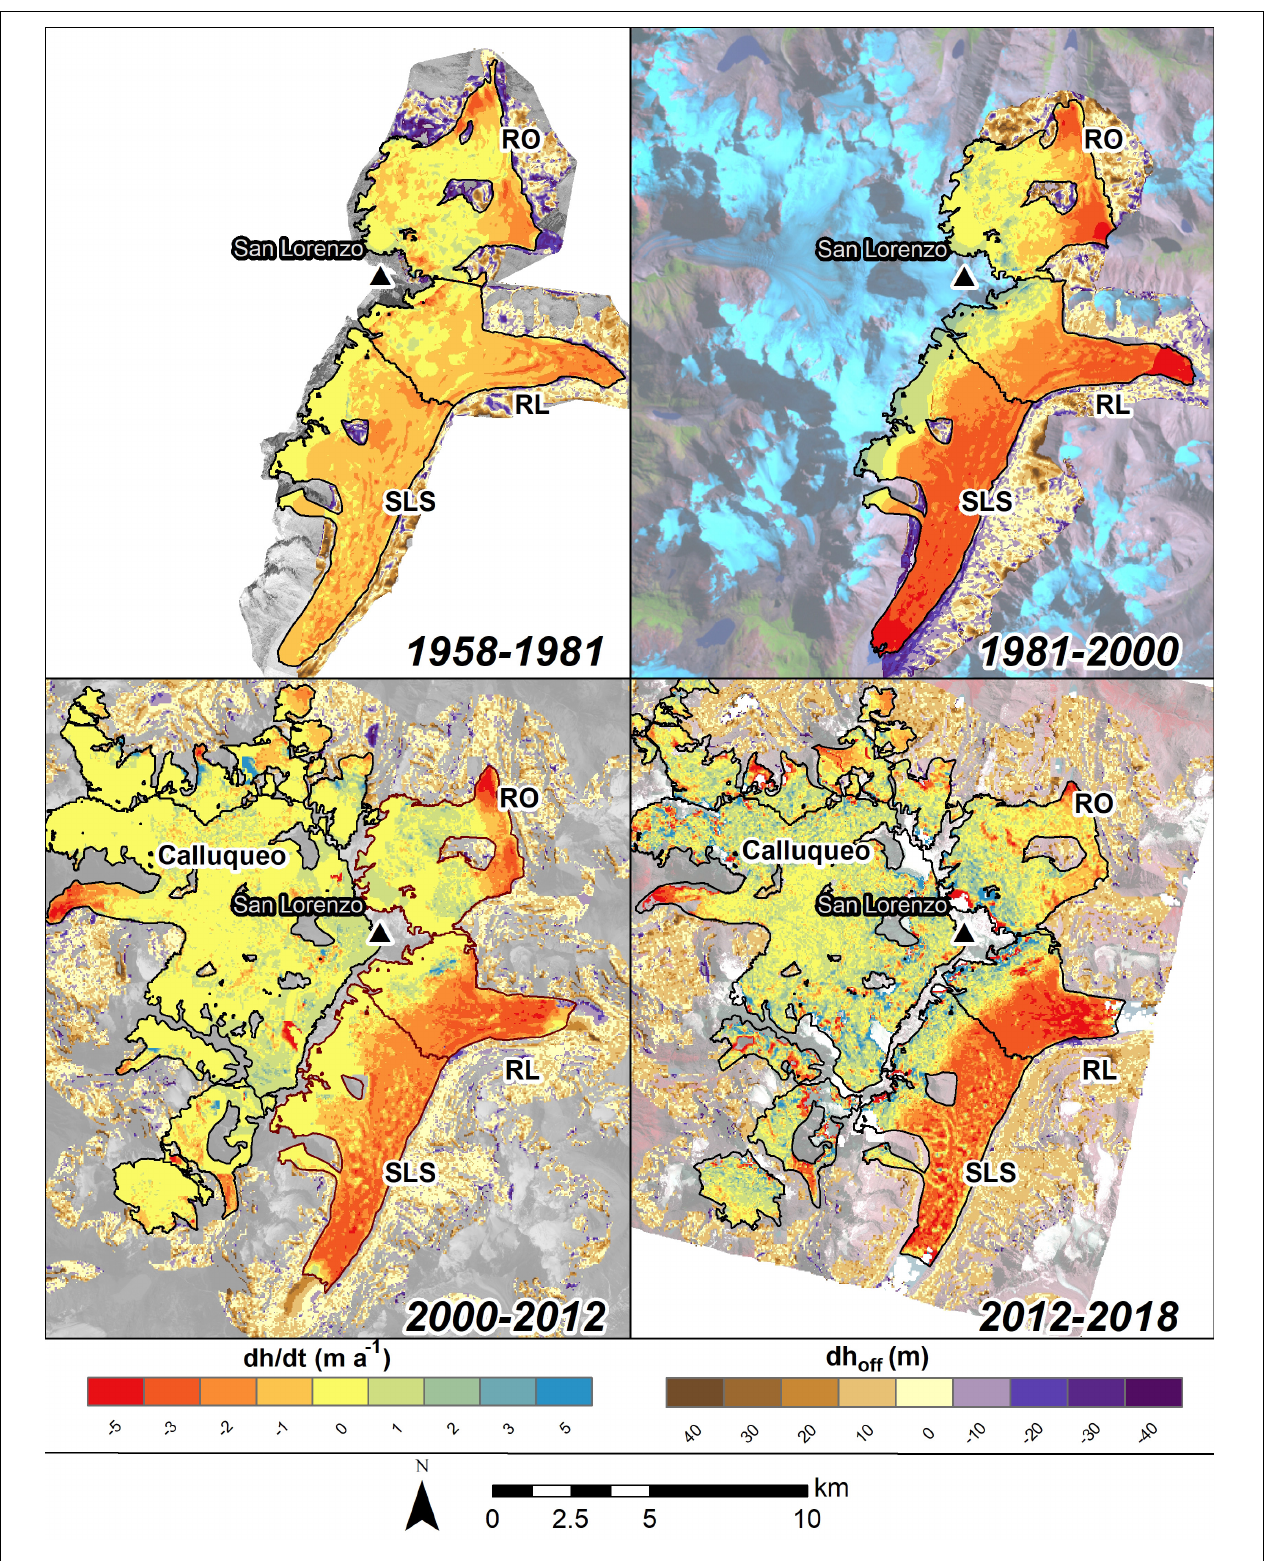
FIGURE 3 | Time-interval glacier annual elevation changes for Rio Oro, Río Lácteo, and San Lorenzo Sur (1958–2018) and the entire San Lorenzo massif (2000–2018). Also shown are elevation changes on stable terrain.